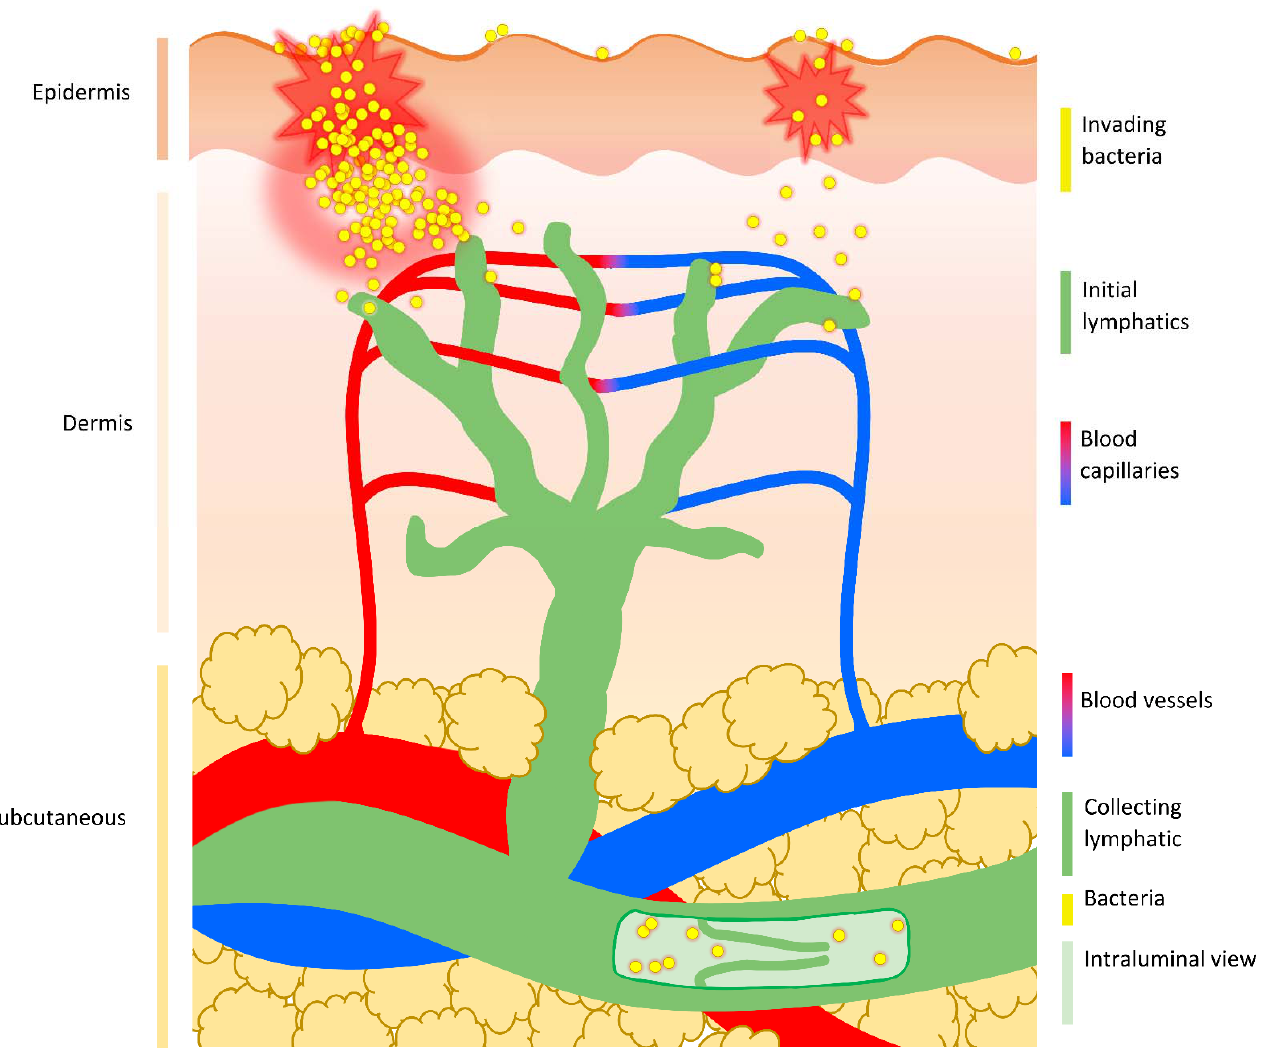
Figure 2. Route of bacterial dissemination from the skin. Following damage to the superficial epidermis of the skin, bacteria can either multiply at the peripheral site generating inflammation and promoting tissue damage, or passively move through the breached barrier and into underlying tissue without creating noticeable signs of infection at the site of entry (as hypothesised in cryptic infections). While the epidermis is devoid of any vasculature, blood capillaries and initial lymphatic vessels permeate the dermis. Bacteria are preferentially taken up by dermal lymphatic vessels and transported passively with lymph flow into deeper-lying collecting lymphatics. These larger lymphatic vessels run through the subcutaneous layer, possess secondary valves that prevent backflow, and carry lymph to draining lymph